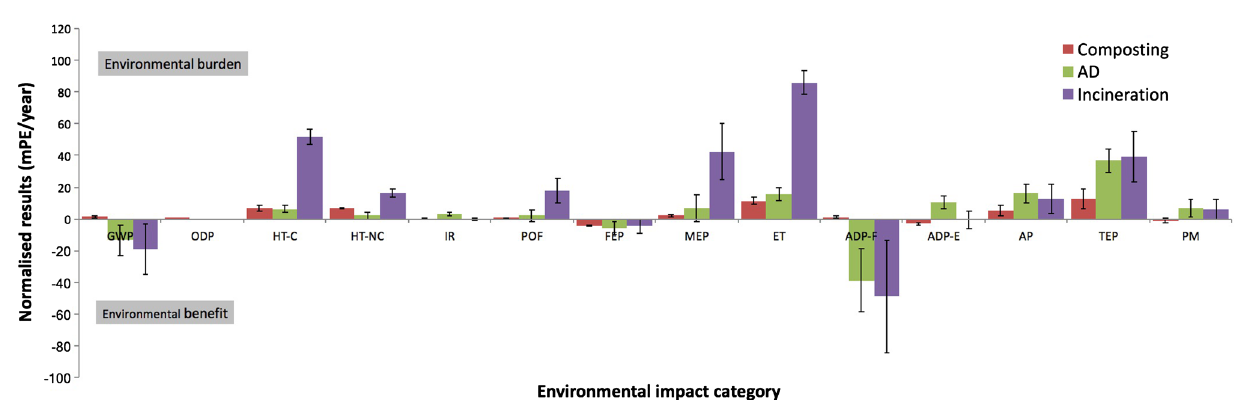
Fig. 3 The normalised environmental and health impacts of three food waste downstream technologies: incineration, composting and AD. Units (mPE) relate a process’ emissions in relation to per capita emissions in the EU in 2010. GWP global warming potential, ODP ozone depletion, HT - C emissions of carcinogens, HT - NC emissions of non-carcinogenic toxins, IR ionising radiation, POF